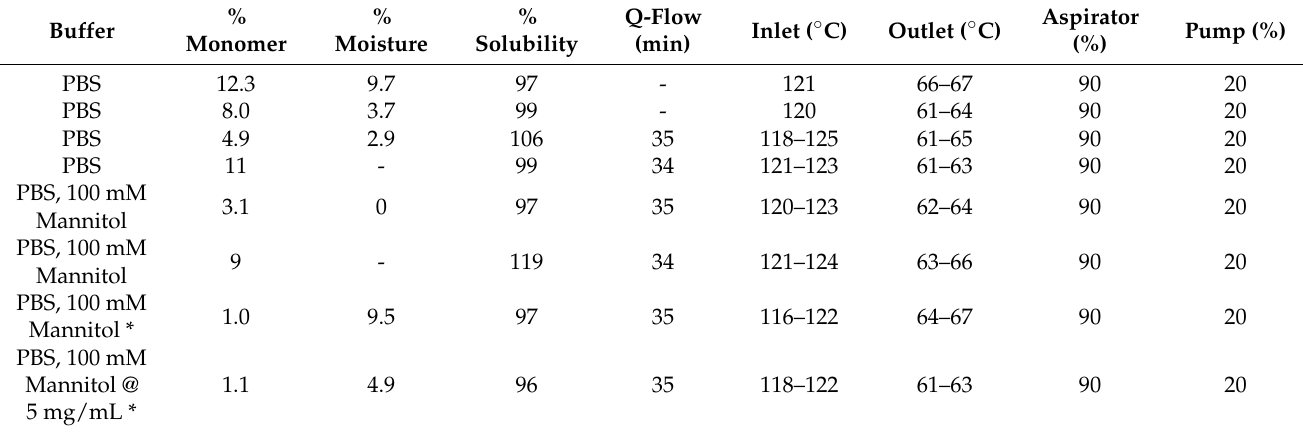
Table 3. Optimization of spray-dry